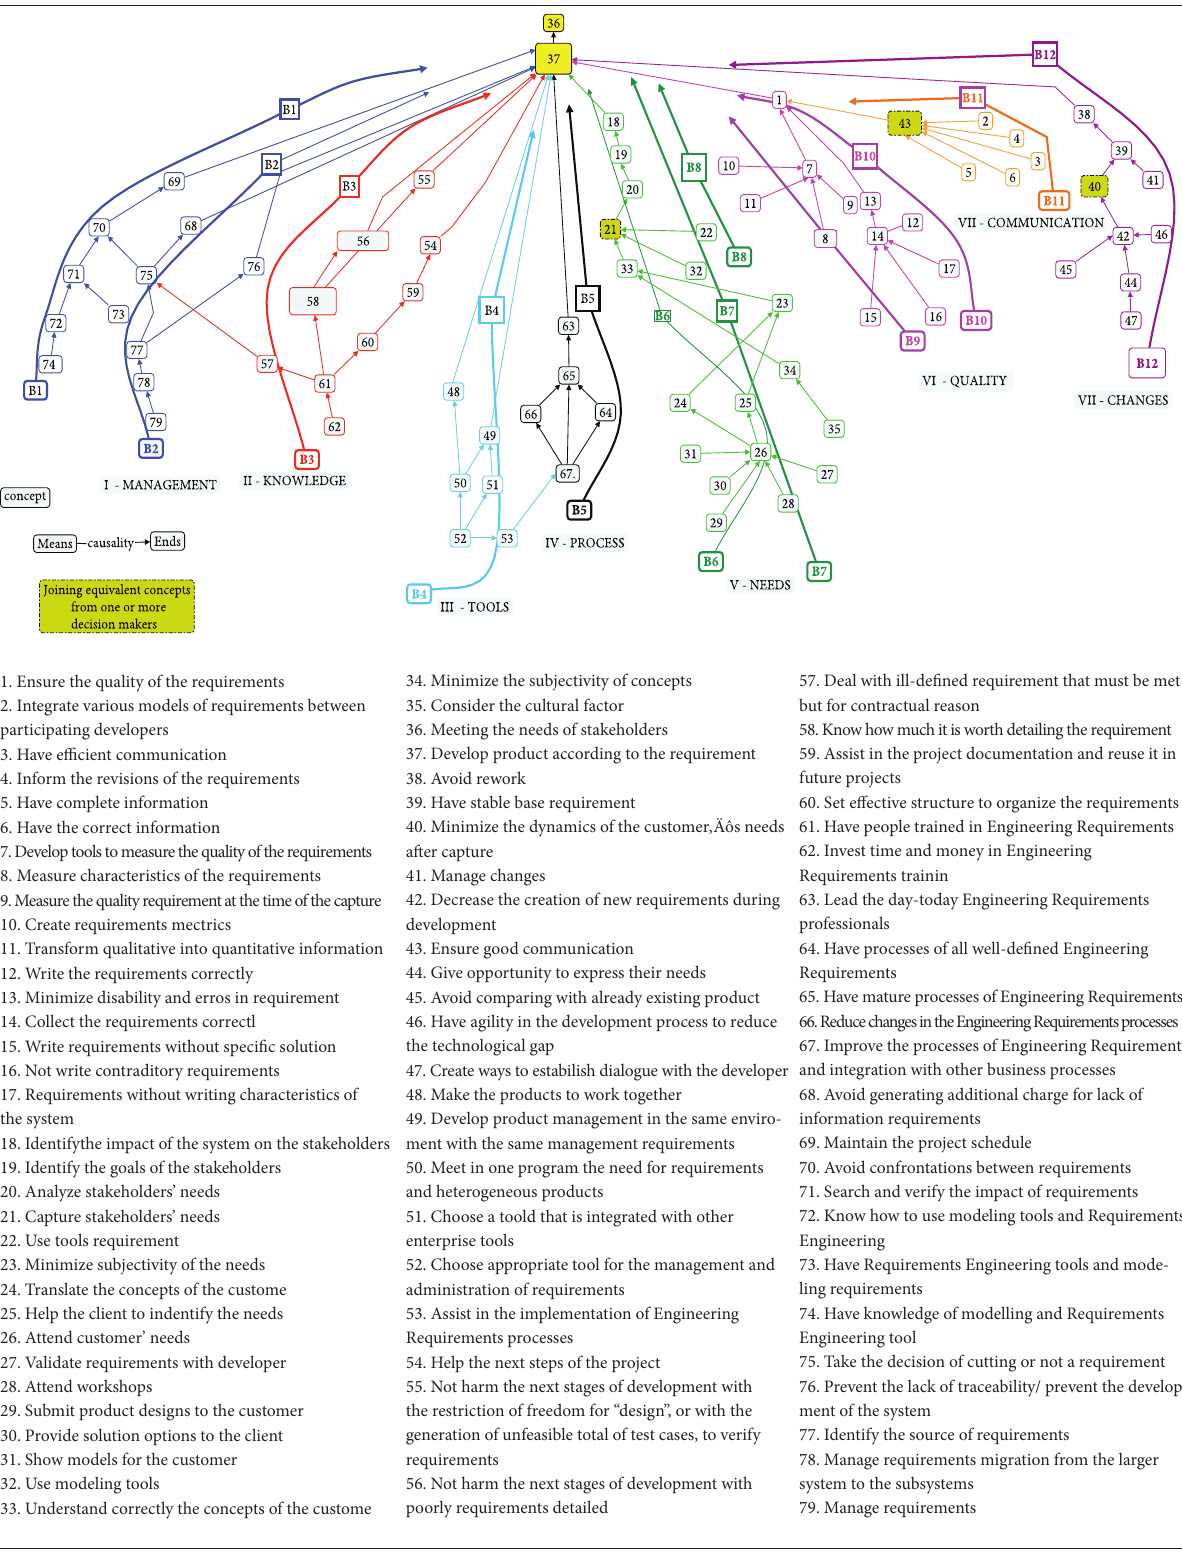
Figure 2. Congregated cognitive map with the clusters